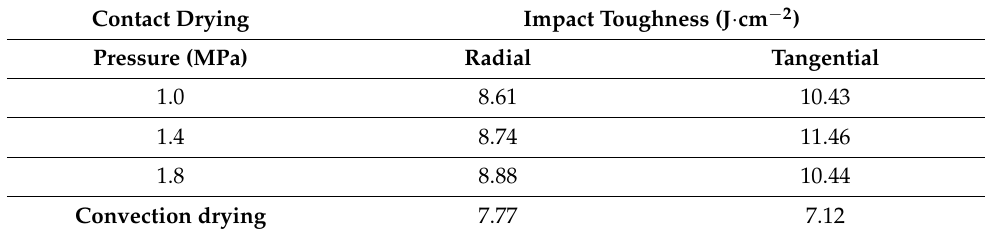
Table 5. Comparison of impact toughness of samples after contact drying and convection